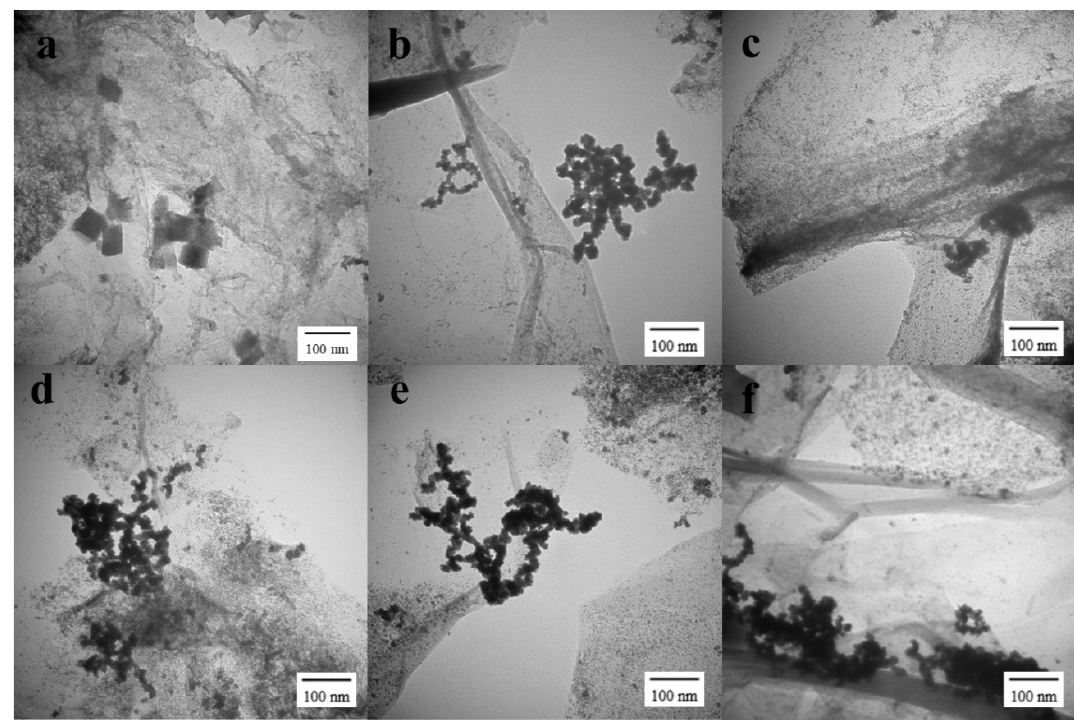
Figure 3. Morphology and structural characterization. TEM images of ( a ) PtNi 2 Co/rGO 200, ( b ) PtNiCo/rGO 200, ( c ) PtNiCo 2 /rGO 200, ( d ) PtNiCo/rGO 160, ( e ) PtNiCo/rGO 180, ( f ) PtNiCo/rGO 220.